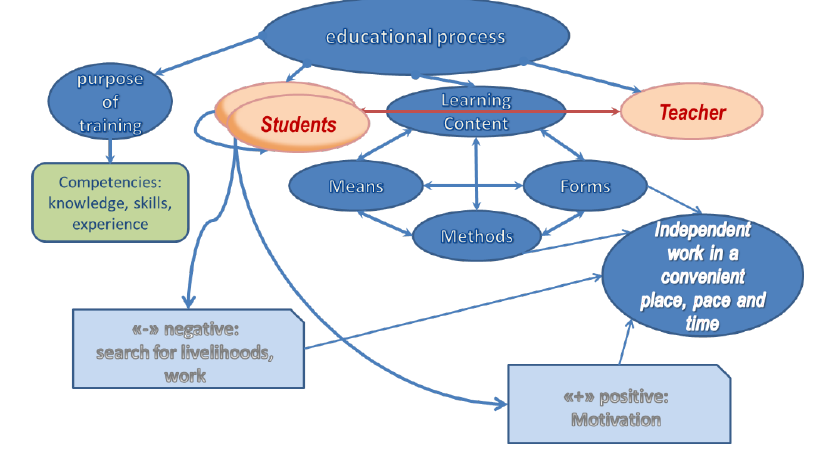
Fig. 2. Educational process and independent